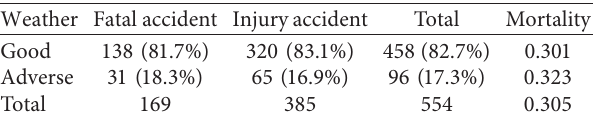
Table 6: Statistical information of weather for injury severity. Weather Fatal accident Injury